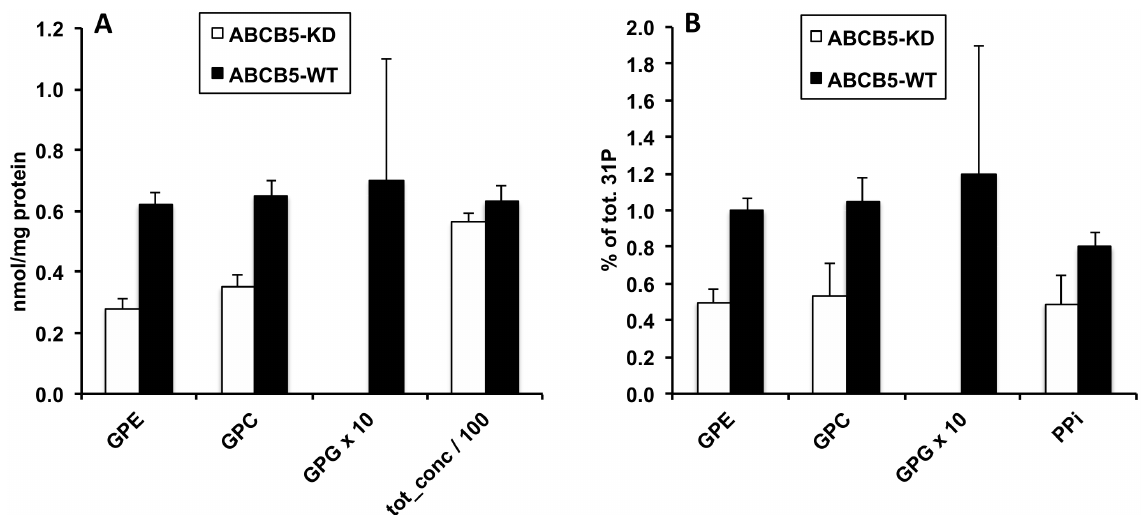
Fig 2. Effects of ABCB5 expression on levels of phosphorylated water-soluble metabolites. Values for human G3361 melanoma cells, measured by 31 P NMR spectroscopy of cell extracts (aqueous phase), are given as means ± SEM, with n = 4 for each group. Open bars, ABCB5-KD cells; full bars, ABCB5-WT cells. Differences between ABCB5-KD and ABCB5-WT cells were significant; detailed statistical results for these metabolites are provided in Table 2. A: Absolute metabolite concentrations, nmol/mg protein. B: Relative metabolite concentrations, % of total 31 P NMR metabolite signals Abbreviations: GPE, glycerophosphorylethanolamine; GPC, glycerophosphorylcholine; GPG, glycerophosphorylglycerol; PPi, pyrophosphate; tot_conc, total concentration of all water-soluble metabolites measured by 31 P NMR spectroscopy.